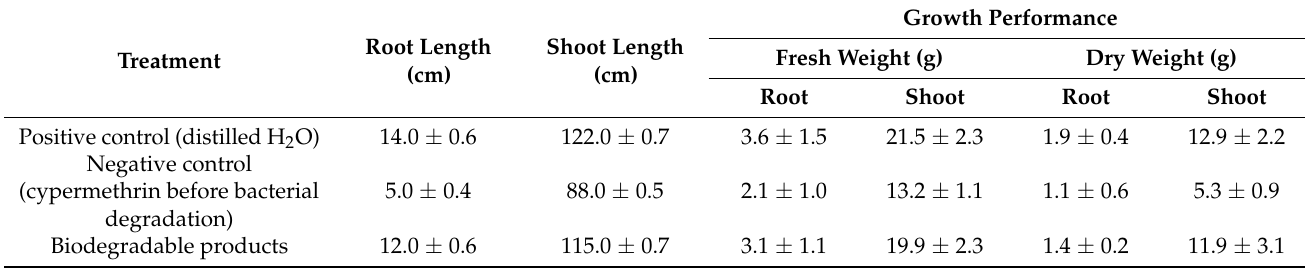
Table 3. Effect of cypermethrin and its biodegradable end products on growth performance of Zea mays plant.